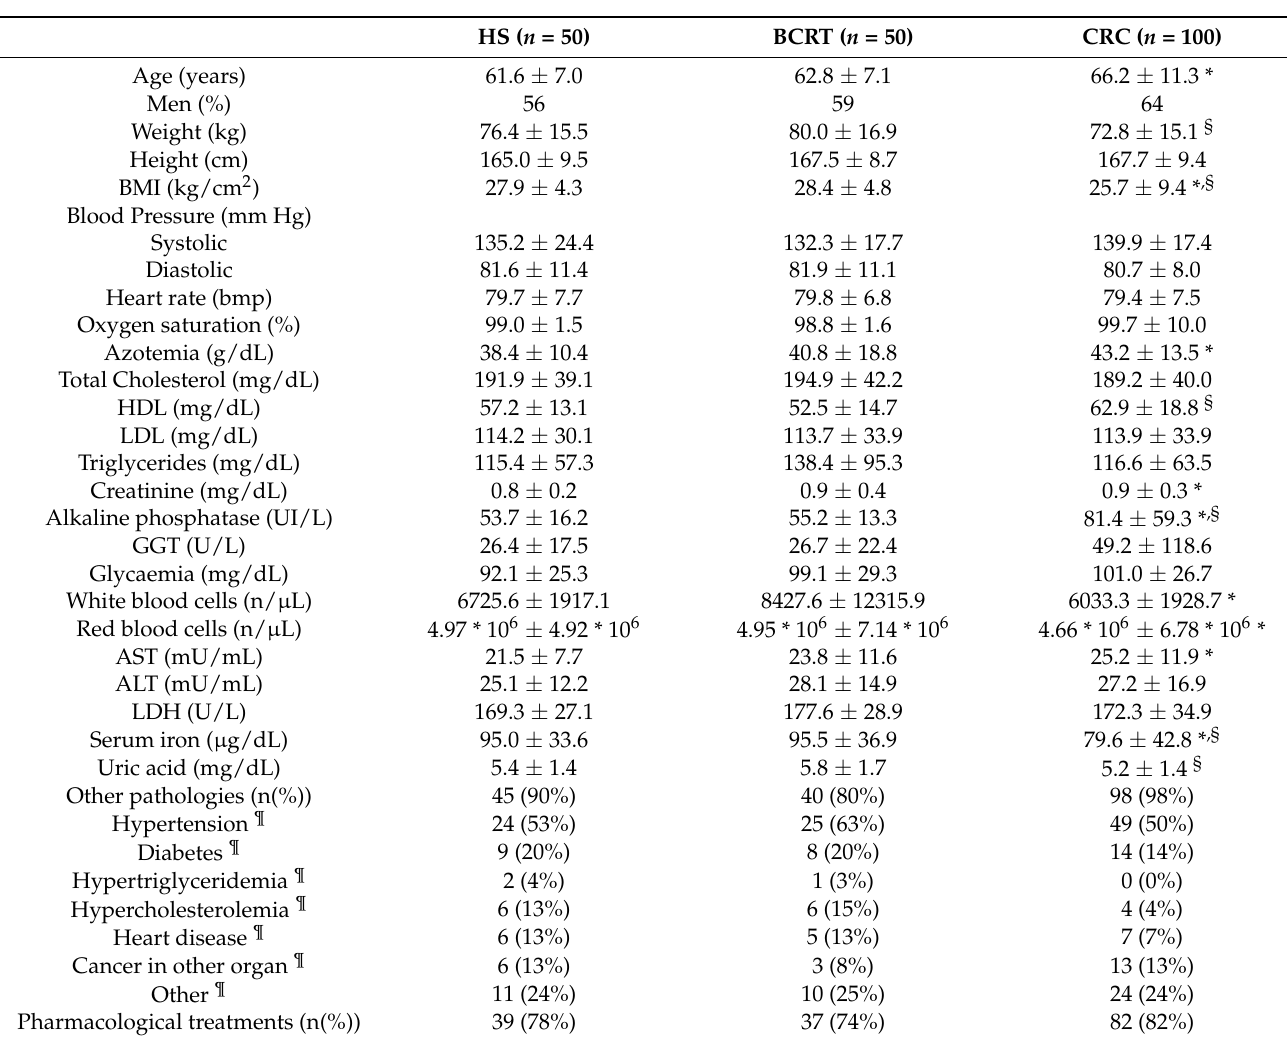
Table 1. Enrolled subject characteristics (mean ± standard deviation or %). Abbreviations used are HS: Healthy subjects, BCRT: Benign colon or rectum tumors, CRC: Colorectal cancer affected patients, BMI: Body mass index, HDL: High-density lipoprotein, LDL: Low-density lipoprotein, GGT: Gamma-glutamyltransferase, AST: Aspartate aminotransferase, ALT: Alanine transaminase